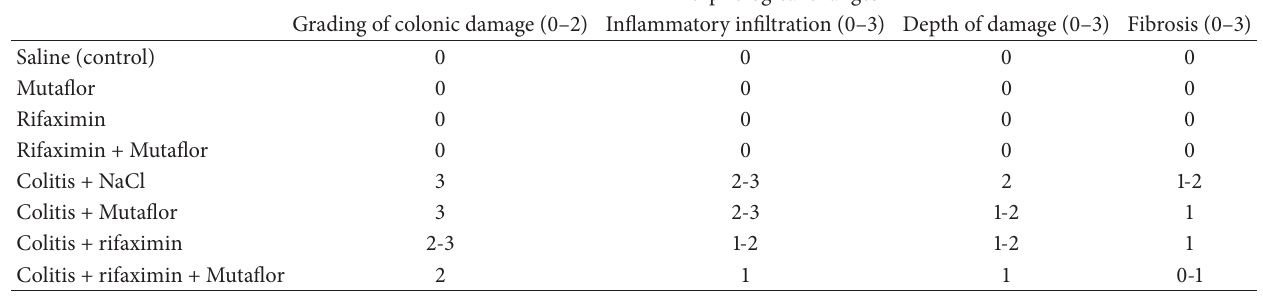
Figure 1: Influence of E. coli Nissle 1917 (Mutaflor) and rifaximin on the area of colonic lesions in rats without or with acetic acid-induced colitis. Mean value ± SEM. 𝑁 = 8 animals in each experimental group. a 𝑃 < 0.05 compared to control saline-treated rats without induction of colitis; b 𝑃 < 0.05 compared to colitis + NaCl; c 𝑃 < 0.05 compared to colitis + Mutaflor; and d 𝑃 < 0.05 compared to colitis + rifaximin. Table 1: Influence of Escherichia coli Nissle 1917 (Mutaflor) and rifaximin on morphological signs of colonic damage in rats without or with acetic acid-induced colitis observed 8 days after rectal administration of saline or acetic acid solution (colitis). Morphological